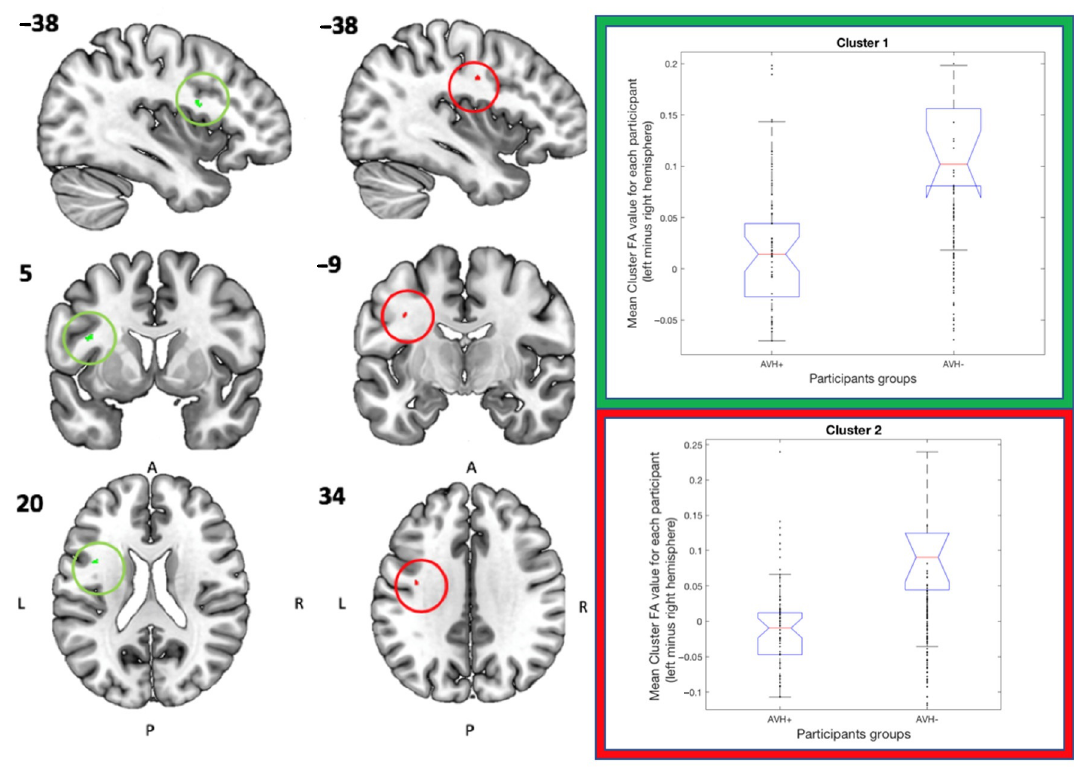
Figure 2. The localization of significant Cluster 1 is marked in green and localization of Cluster 2 is marked in red, see Table 3 for further details regarding localization and size of the two clusters. The box plot graphs represent the corresponding mean asymmetry FA-values (left minus right hemisphere, see Y -axis) for each participant in each group. The color of the graph frame matches the colors of the cluster it belongs to. The central mark indicates the median, and the top and bottom edges of the box represents 25th and 75th percentiles, respectively. The whiskers extend to the most extreme data points not considered outliers and the outliers are plotted individually and marked with a plus symbol.